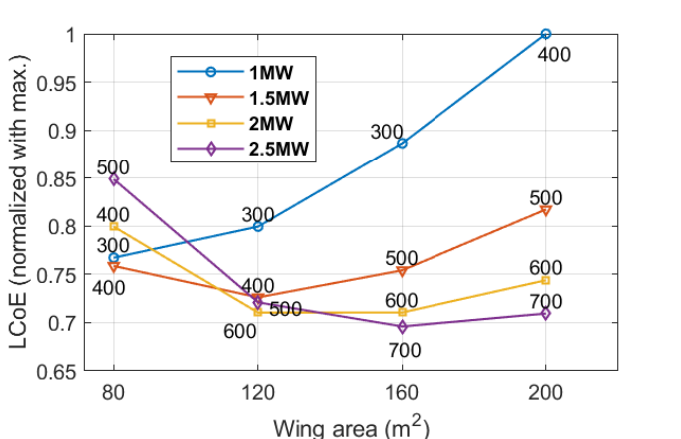
Figure 12. Minimum LCoE trend for the onshore business case. The labels at the data points quantify the F t,max in